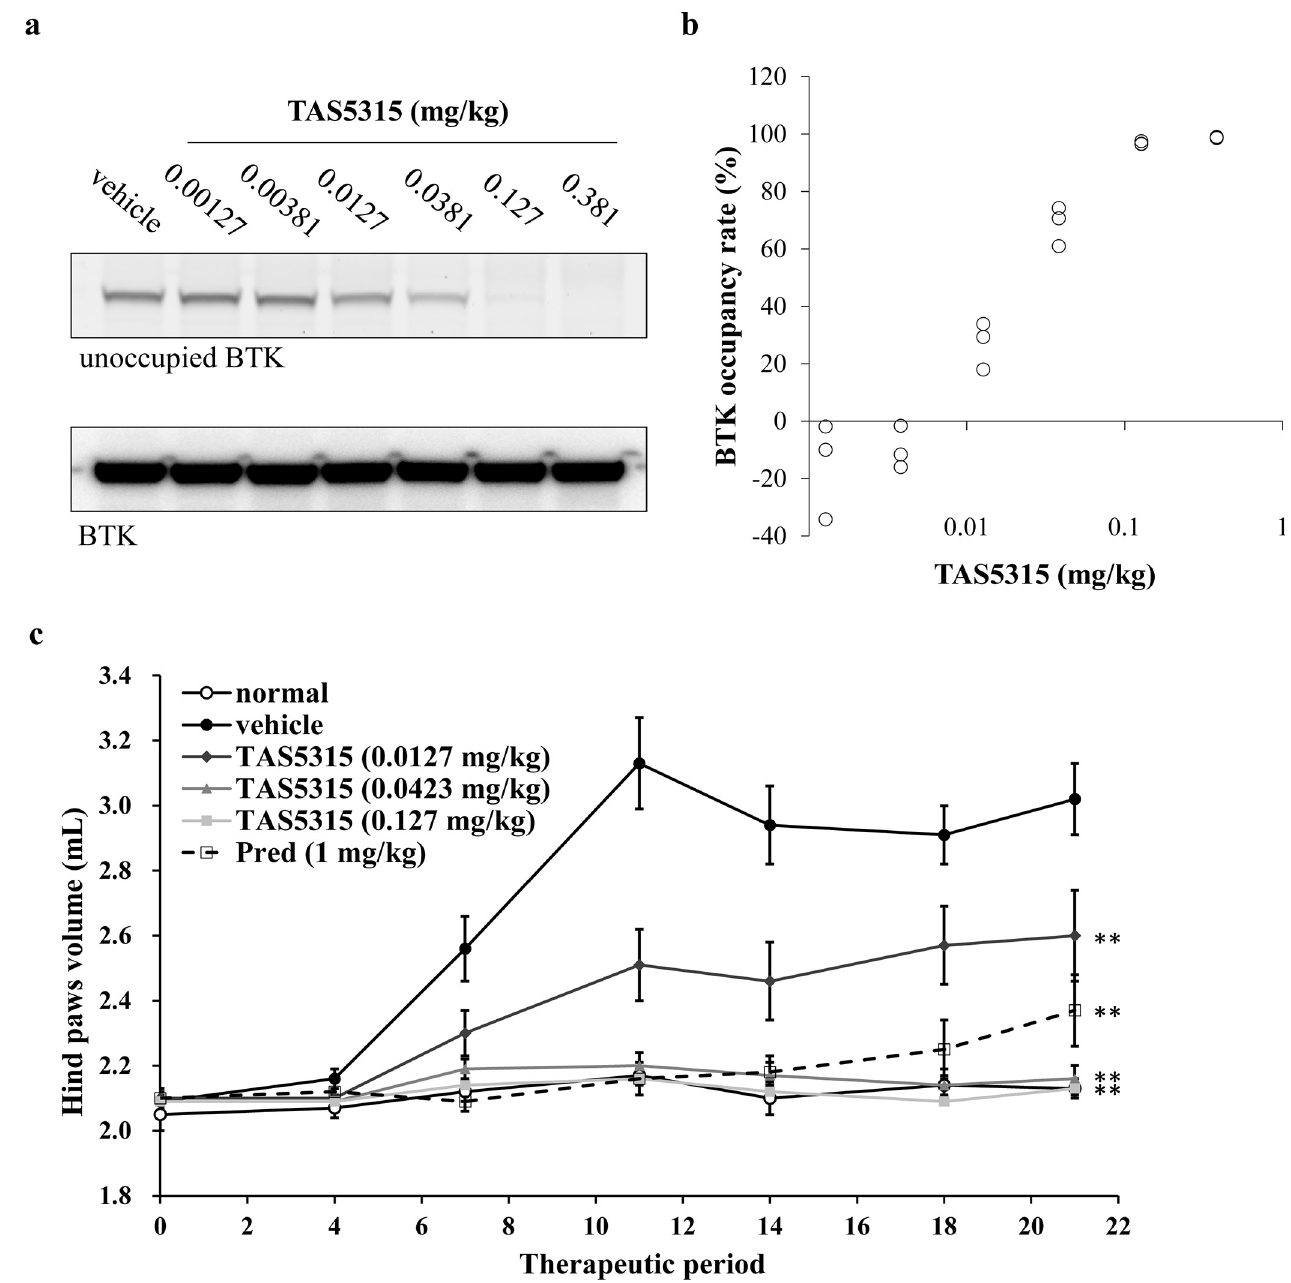
Fig 4. Anti-inflammatory effect of TAS5315 in a rat CIA model. (a, b) BTK occupancy by TAS5315 in PBMCs from rats at 6 h after administration. BTK that was not occupied by TAS5315 was detected with a BODIPY probe ( n = 3). (a) Representative data for the BTK occupancy assay. (b) Each BTK occupancy rate indicates the percentage (%) at which the fluorescence intensity of background and vehicle-treated rat PBMC samples were 0% and 100%, respectively. (c) Hind paw volumes in the rat CIA model. Experimental arthritis was induced by two immunizations with collagen and incomplete Freund’s adjuvant. For 21 days from the second immunization (Day 1), rats were administered once daily with vehicle, TAS5315, or prednisolone (Pred) ( n = 6–10 per group). Data are presented as mean ± SEM. �� P < 0.01 compared with the vehicle group (Dunnett test for TAS5315 groups, Student’s t-test for Pred